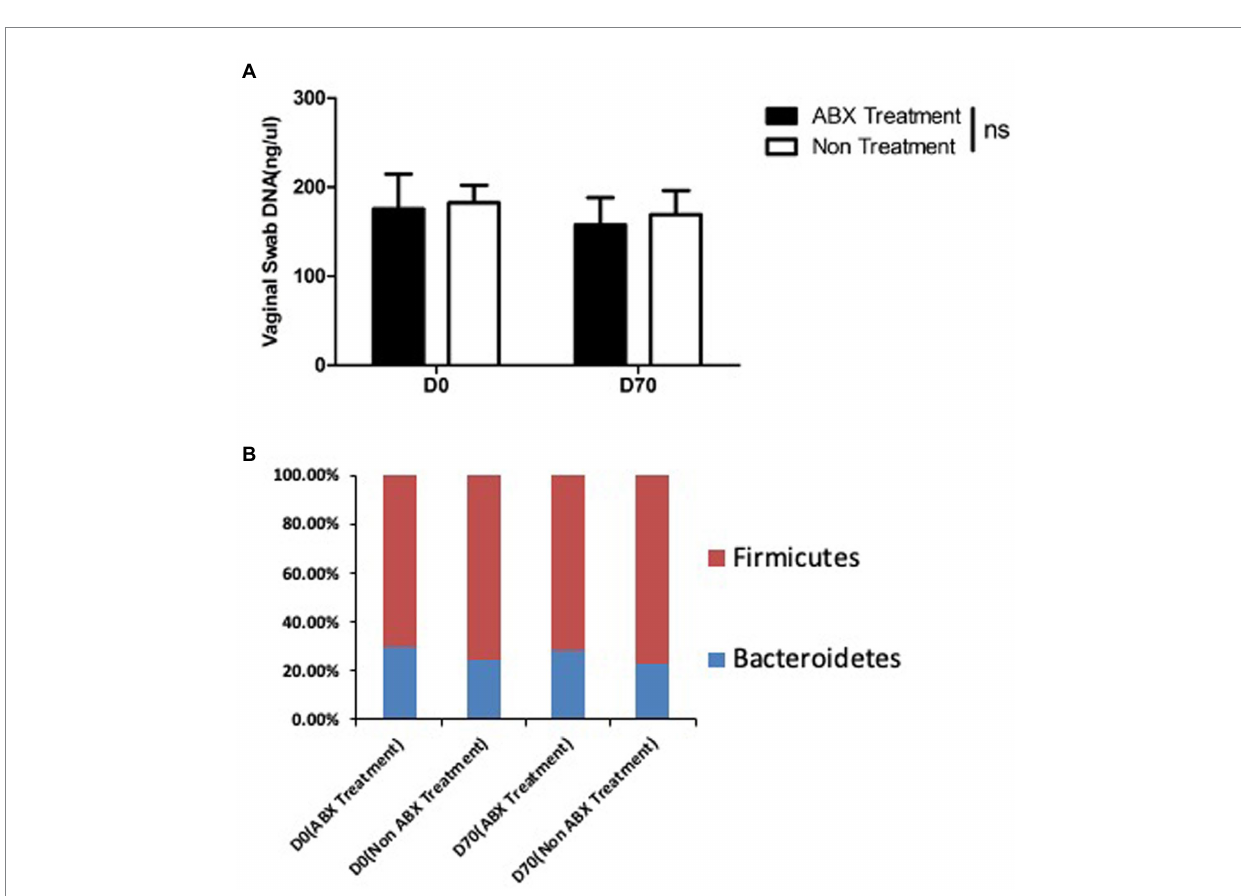
FIGURE 4 Oral antibiotics treatment fails to alter vaginal microbiota. Female DBA2/J mice were treated without (Non, n = 20) or with (ABX, n = 20) oral antibiotics for 21 days (D0 or prior to infection) or 91 days (D70, 70 days after infection) as described in Figure 1 legend. Vaginal swabs were taken for extracting DNA (panel A ) and detecting the relative abundance of 16S rRNA gene from bacterial phyla bacteroidetes (blue, panel B ) and firmicutes (red, panel B ) using. Neither the vaginal DNA amount nor the relative abundance of bacteroidetes and firmicutes in the vaginal swabs was different between mice with or without the oral antibiotics treatment for 21 or 91 days ( p > 0.05,